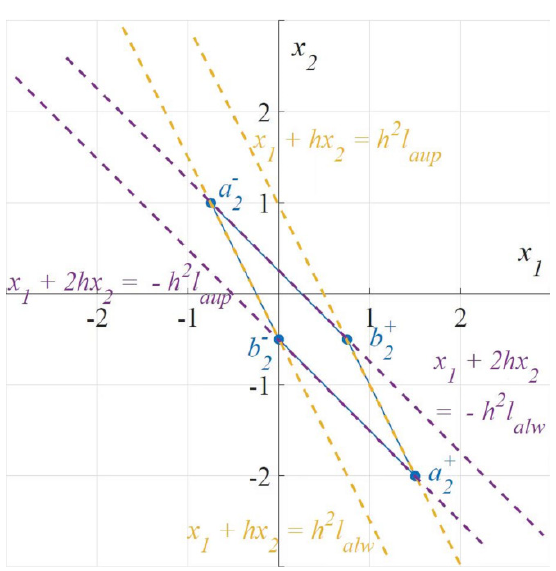
Figure 4. Boundary line diagram. Reprinted with permission from refs. [16,17].